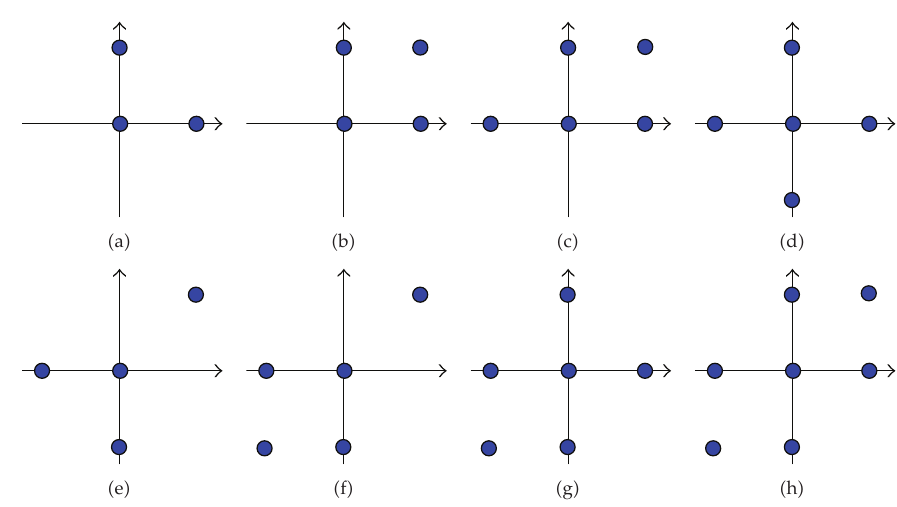
Figure 11: The most popular a ffi ne Calabi-Yau threefold toric diagrams, corresponding, respectively, to (cid:5) a (cid:6) C 3 , (cid:5) b (cid:6) conifold, (cid:5) c (cid:6) SPP, (cid:5) d (cid:6) F (cid:5) e, f, g, h (cid:6) dP 0 , and 0 , 1 , 2 , 3 . The end points are at the standard lattice points in Z 2